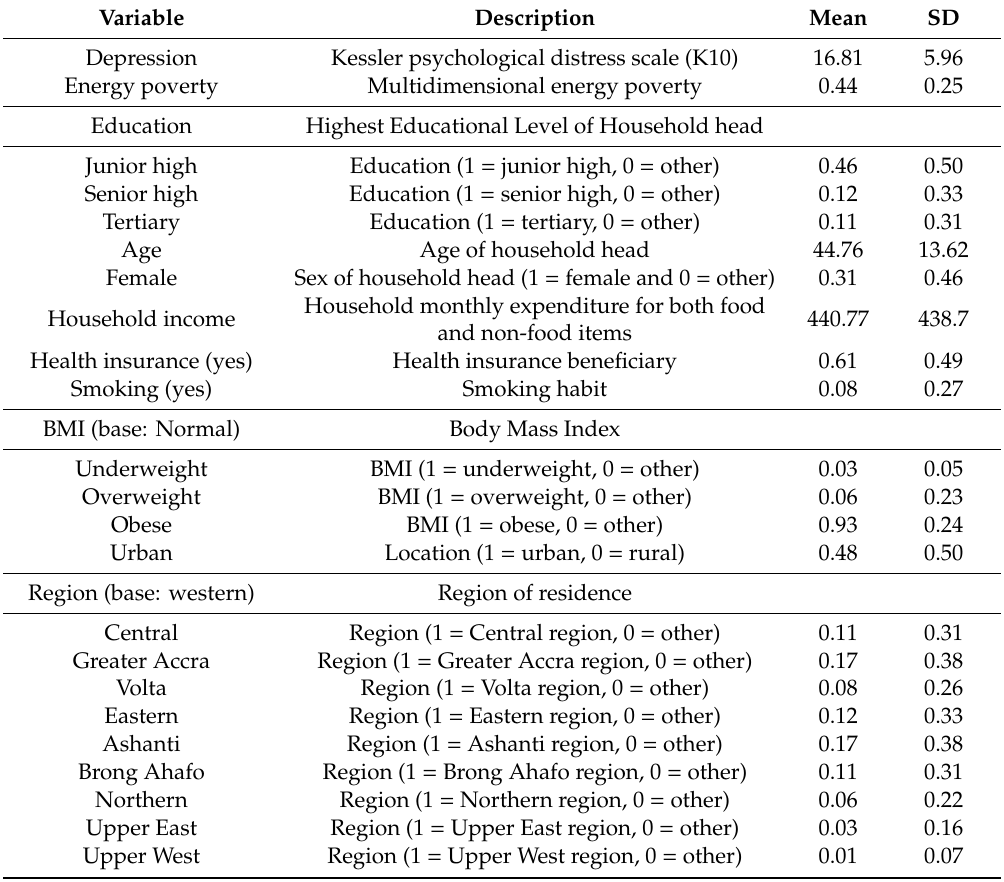
Table A2. Description and summary statistics of